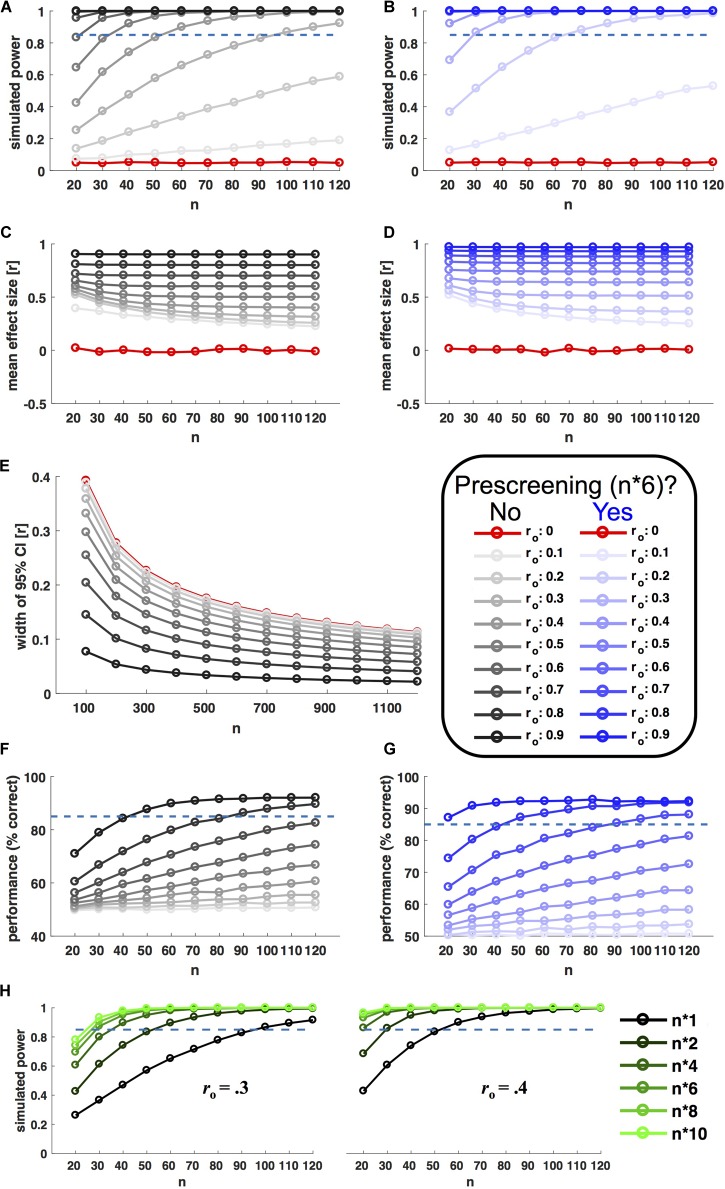
Selective sampling. Left hand plots in black ink show power simulations without prescreening; right hand plots in blue show corresponding results for prescreening with selective sampling of extreme groups. Selective samples were drawn based on behavioral measures from a prescreening group six times the size of n (extreme groups for B,D, even sampling for G). In each panel, ink saturation indicates the simulated effect size on the population level, as shown in the inset (observable correlation ro). Red ink indicates simulation results for zero-effects (ro = 0). All x axes indicate sample size n (10.000 random samples drawn for each level). (A,B) Shows power, i.e., the fraction of samples showing a statistically significant correlation (P < 0.05). (C,D) Shows corresponding effect sizes (mean of observed significant correlations). (E) Shows the (inverse) precision of effect size estimates (width of 95% confidence interval) as a function of observed effect size and sample size. (F,G) Shows the accuracy of a model selection procedure aiming to distinguish between linear and non-linear relationships based on simulated data (see main text for details). (H) Shows the power boost afforded by different prescreening factors, for two different observable effect sizes (ro = 0.3/0.4, as shown). The prescreening factor corresponds to the size of the prescreening sample divided by the final n, as shown in the legend to the right.